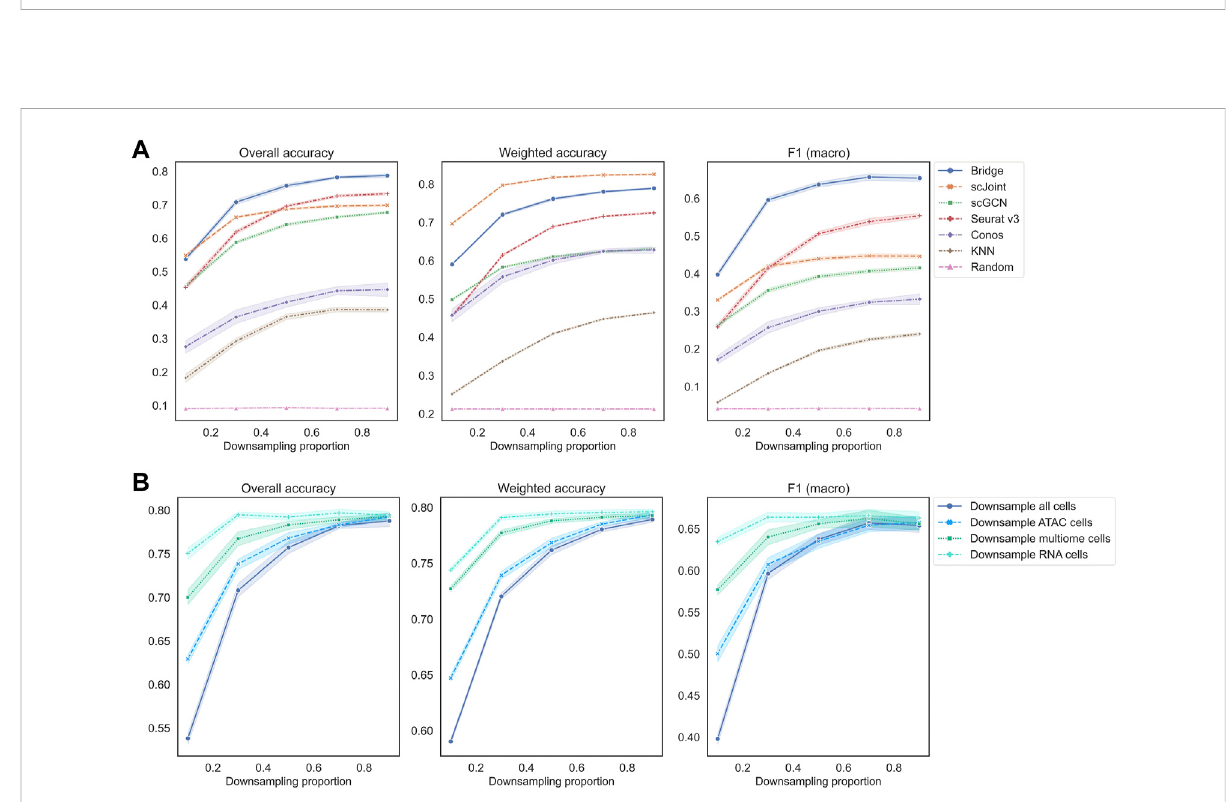
FIGURE 5 PerformanceofmethodsondifferentdownsamplingproportionsofBMMC. (A)